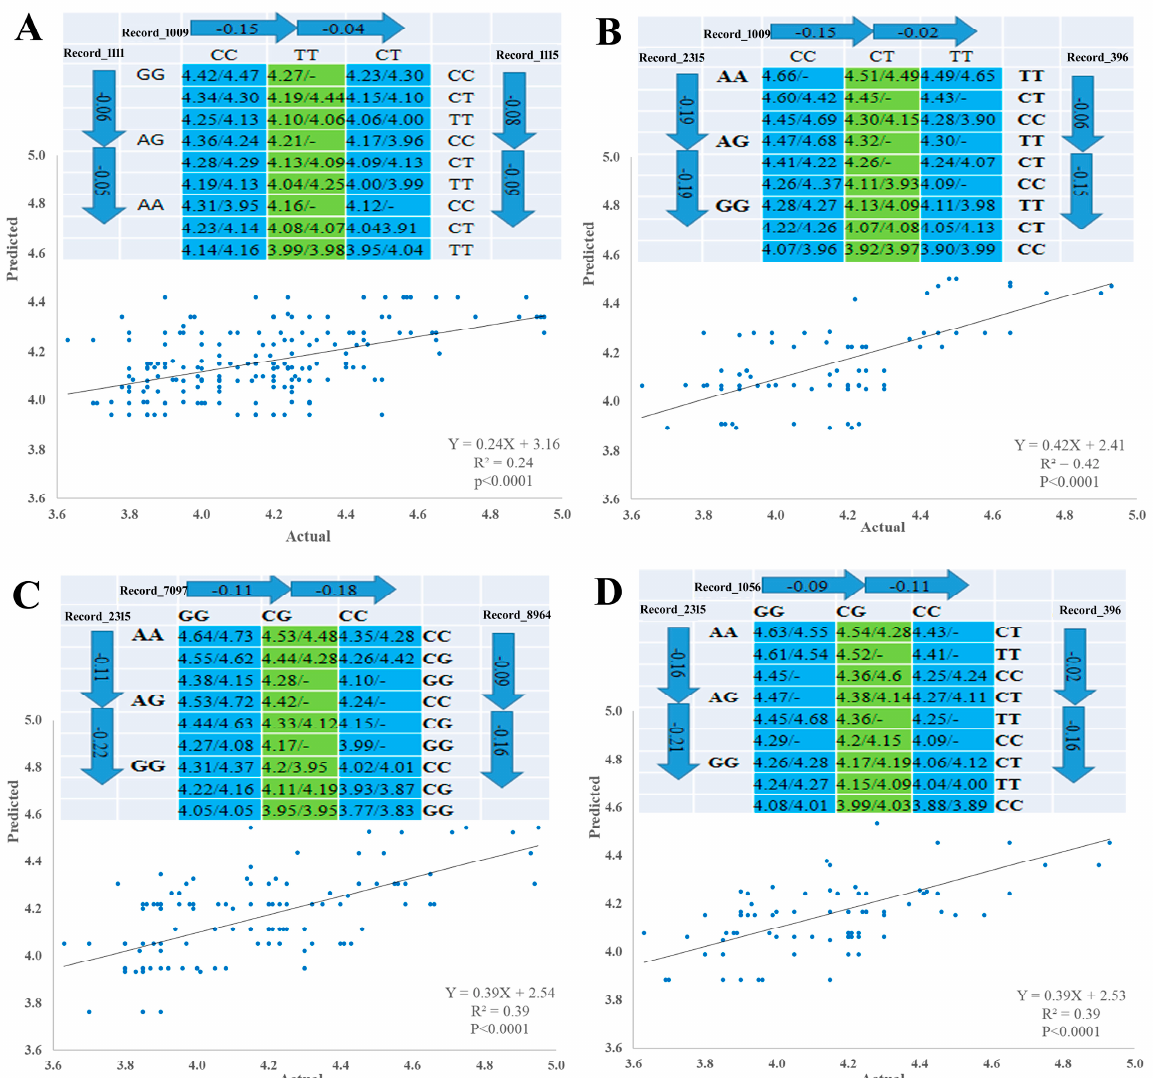
Figure 4. Genetic networks with multiple SNPs for marketing weight of male goslings. ( A ) Three SNP-networks for SNPs Record_1111, Record_1009 and Record_1115 (SNP-network 4). ( B ) Three SNP-networks for SNPs Record_2315, Record_1009 and Record_396 (SNP-network 5), ( C ) Three SNP-networks for SNPs Record_2315, Record_7097 and Record_8964 (SNP-network 6), and ( D ) Three SNP-networks for SNPs Record_2315, Record_1056 and Record_396 (SNP-network 7). The X and Y axes represent actual and predicted MW (kg), respectively.